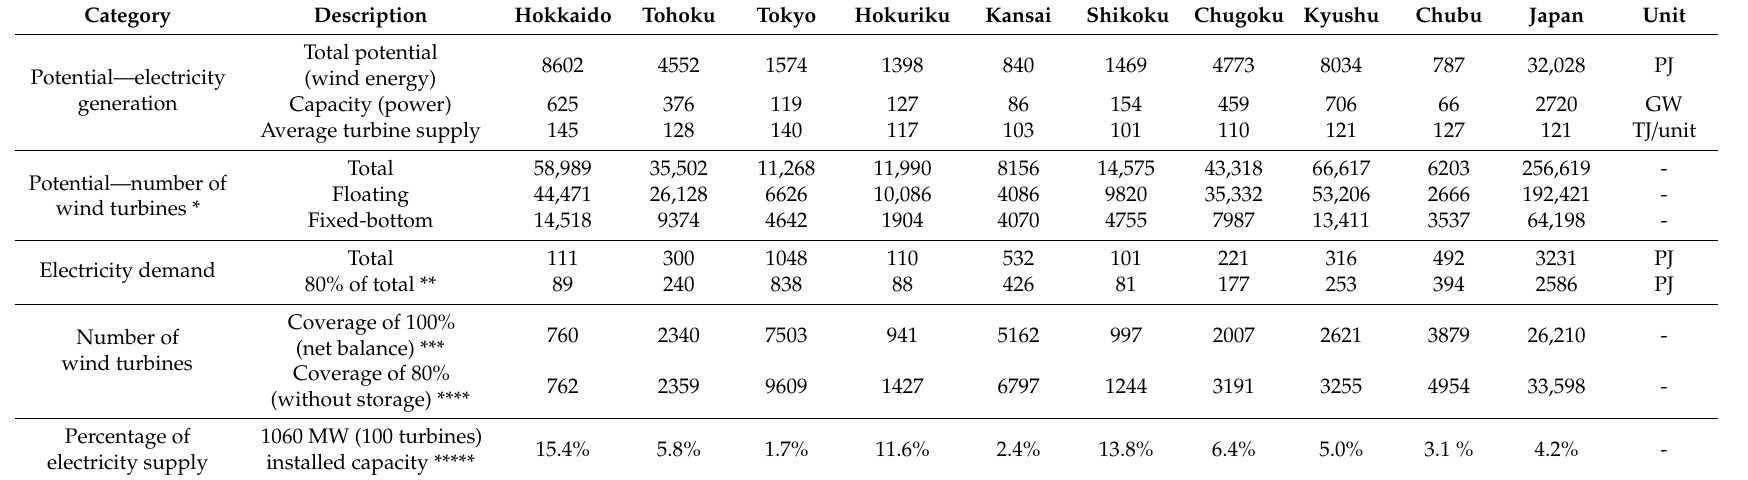
Table 6. O ff shore wind potential for each region in Japan